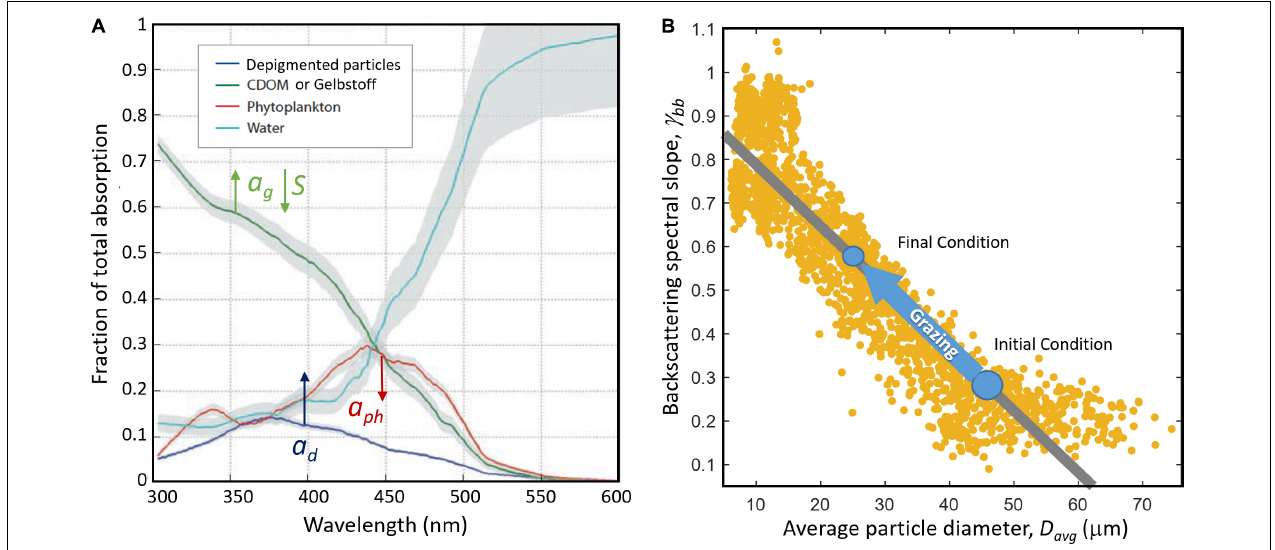
FIGURE 2 | Grazing is hypothesized to change spectral absorption and backscattering across UV and visible wavelengths. (A) As particles are grazed, absorption by gelbstoff ( a g ) may increase and the spectral slope ( S ) may flatten compared to background gelbstoff subject to photobleaching. The contribution of depigmented particle absorption ( a d ) may increase and phytoplankton absorption (a ph ) may decrease as particles are grazed. The relative changes in these components result in spectral dips and troughs that may be observed in the remote sensing reflectance, particularly in sensors that can detect spectral changes in the UV like PACE. Modified from Nelson and Siegel (2013). (B) Backscattering is expected to increase with increased detrital matter produced by grazing. In addition, we hypothesize that the spectral slope of backscattering g γ , will increase as the average particle size decreases with decreasing phytoplankton and increasing detrital particles. Modified from Slade et al. (2015) showing trends in these parameters from field